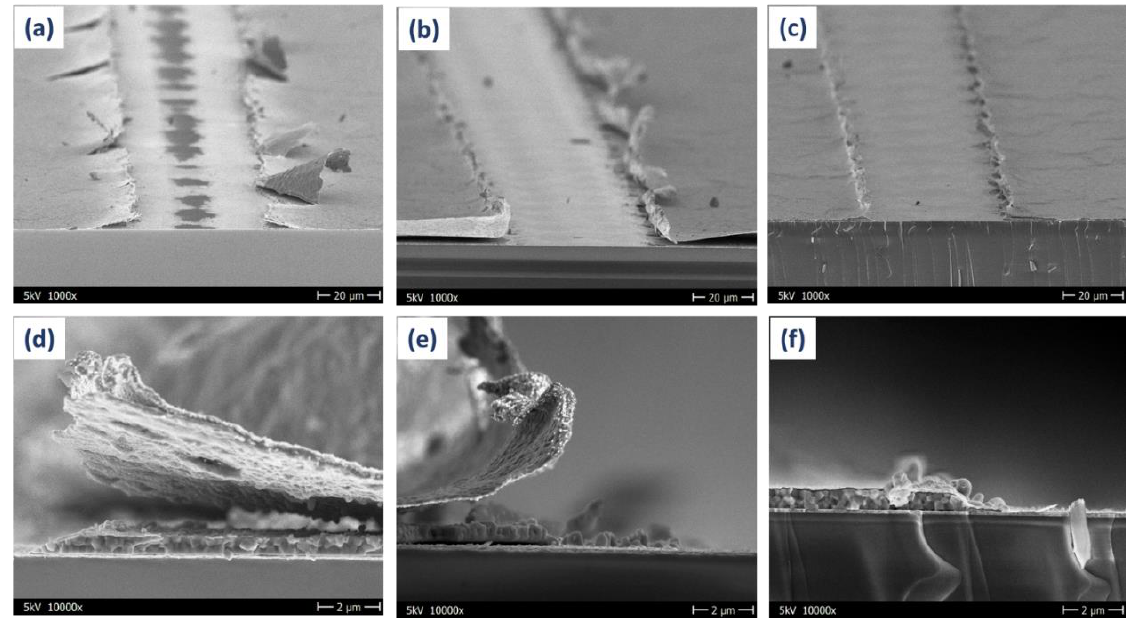
Figure 2. Scanning electron microscopic images of P2 and P3 patterning of ( a , d ) Ag electrode, ( b , e ) Cu electrode and ( c , f ) Cu/Au electrode of a perovskite mini-module.